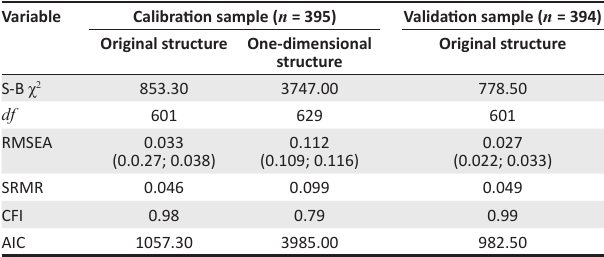
TABLE 2: Summary of the goodness-of-fit statistics of the two random samples. Variable